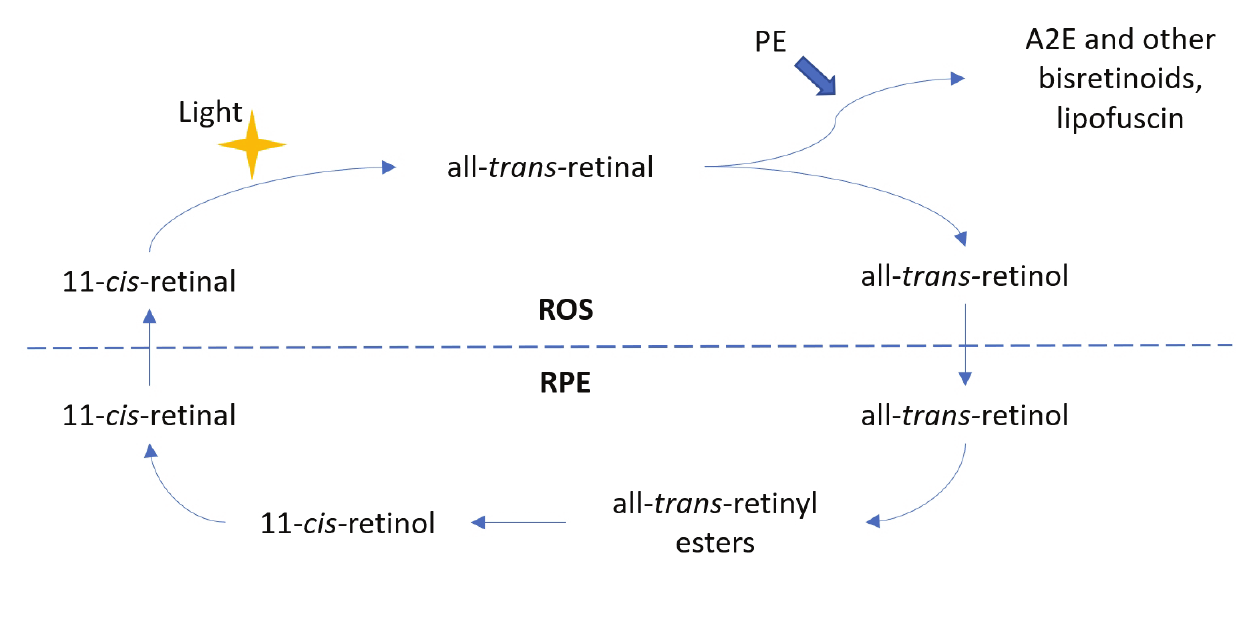
Figure 1. Simplified diagram of the visual cycle and formation of lipofuscin. PE, phosphatidylethanolamine; A2E, N-retinyl-N- retinylidene ethanolamine. The dotted line divides processes occurring in the rod outer segments (ROS) and the retina pigment epithelium